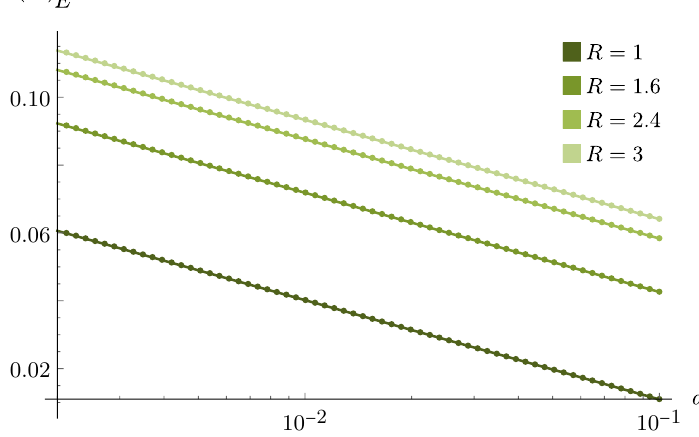
Figure 8 . This log-linear plot shows the functions − A − B ln a (solid curves) that are fitted to the numerical results for L = 100 and r c = 50 (data points) for different values of R . The slopes B ’ 0 . 0127 are equal for all